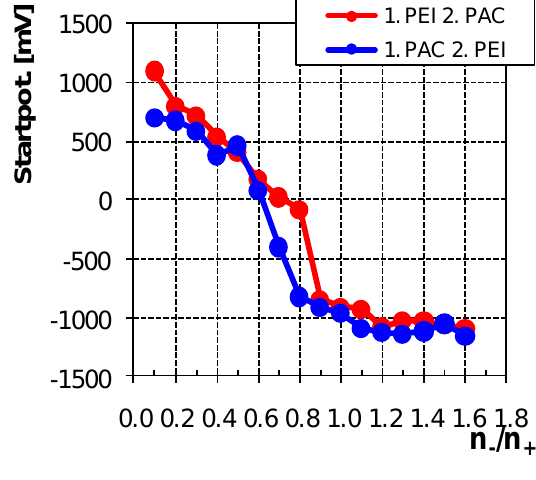
/n , c = 0.001 M, pH = 10/4. − + PEL